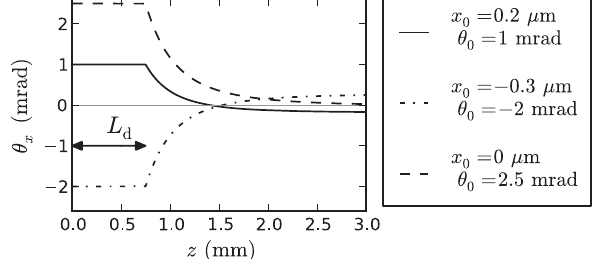
FIG. 1. Evolution of the propagation angle of individual electrons, as predicted by Eq. (4) for several ( x 0 , θ 0 ), and for γ ¼ 400 , Z ¼ 180 μ m, a ð 0 Þ ¼ 5 , w ð 0 Þ ¼ 6 . 7 μ m, and η ¼ 1 . R 0 In the drift space ( z < L d ), Eq. (4) does not apply, and instead θ x remains